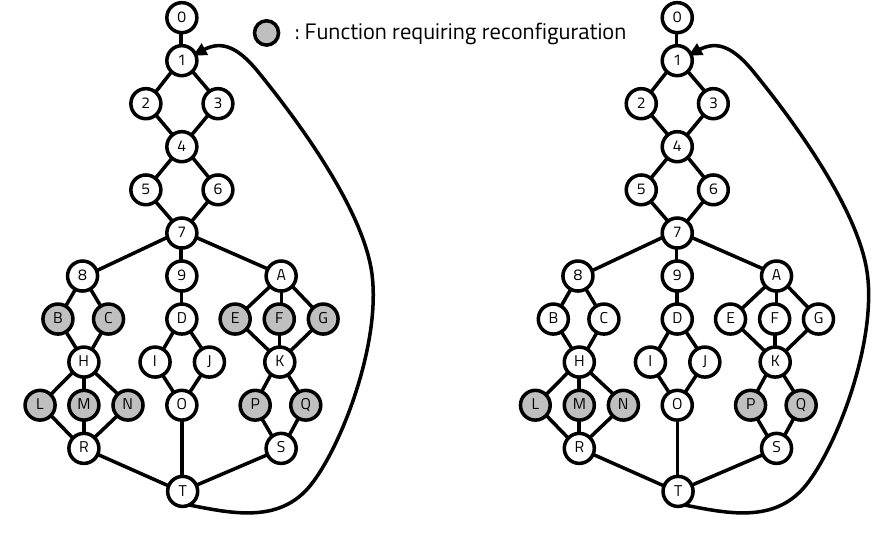
Figure 14. Application’s control